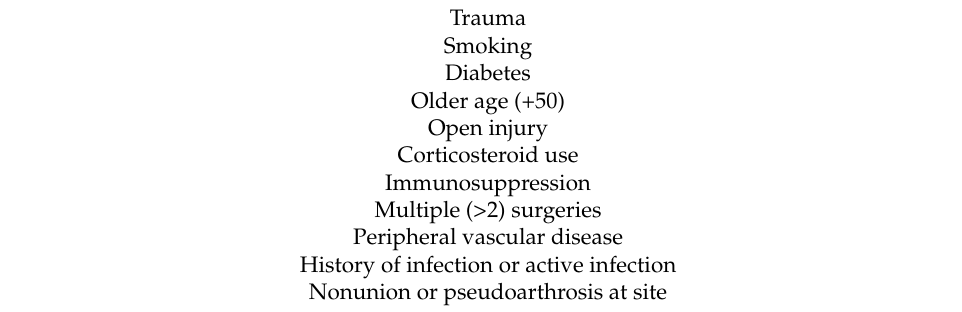
Table 2. Summary of risk factors for impaired bone